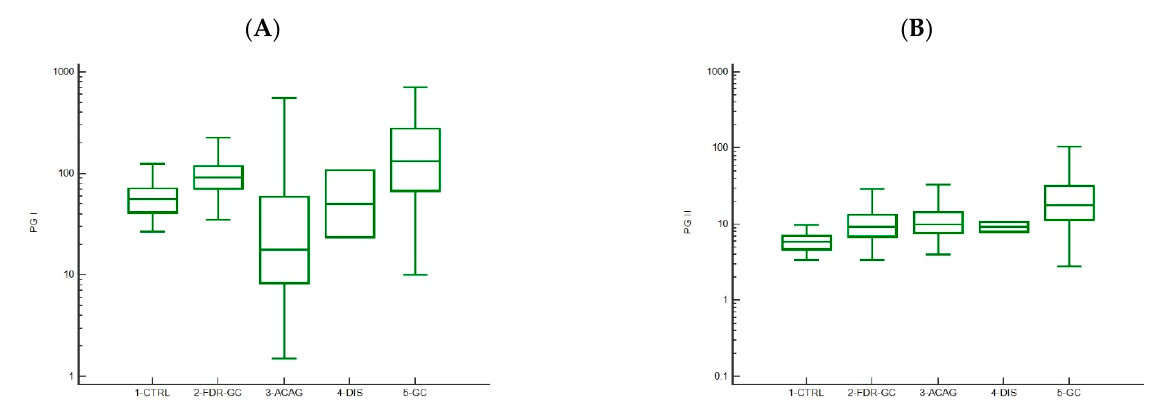
Figure 2. Serum levels of pepsinogen I and II, by study group. The boxes indicate the median and 25th and 75th percentiles, and the outside whiskers indicate the range. ( A ) Pepsinogen I. Kruskal-Wallis test, p < 0.0001, Jonckheere-Terpstra test for trend not significant. ( B ) Pepsinogen II. Kruskal-Wallis test, p < 0.0001, Jonckheere-Terpstra test for trend p < 0.0001, significantly different ( p < 0.05) average rank (Conover analysis). CTRL, controls; FDR-GC, first-degree relatives of gastric cancer patients; ACAG, autoimmune chronic atrophic gastritis; DIS, dysplasia; GC, gastric cancer. Table 4. Serum markers, by study